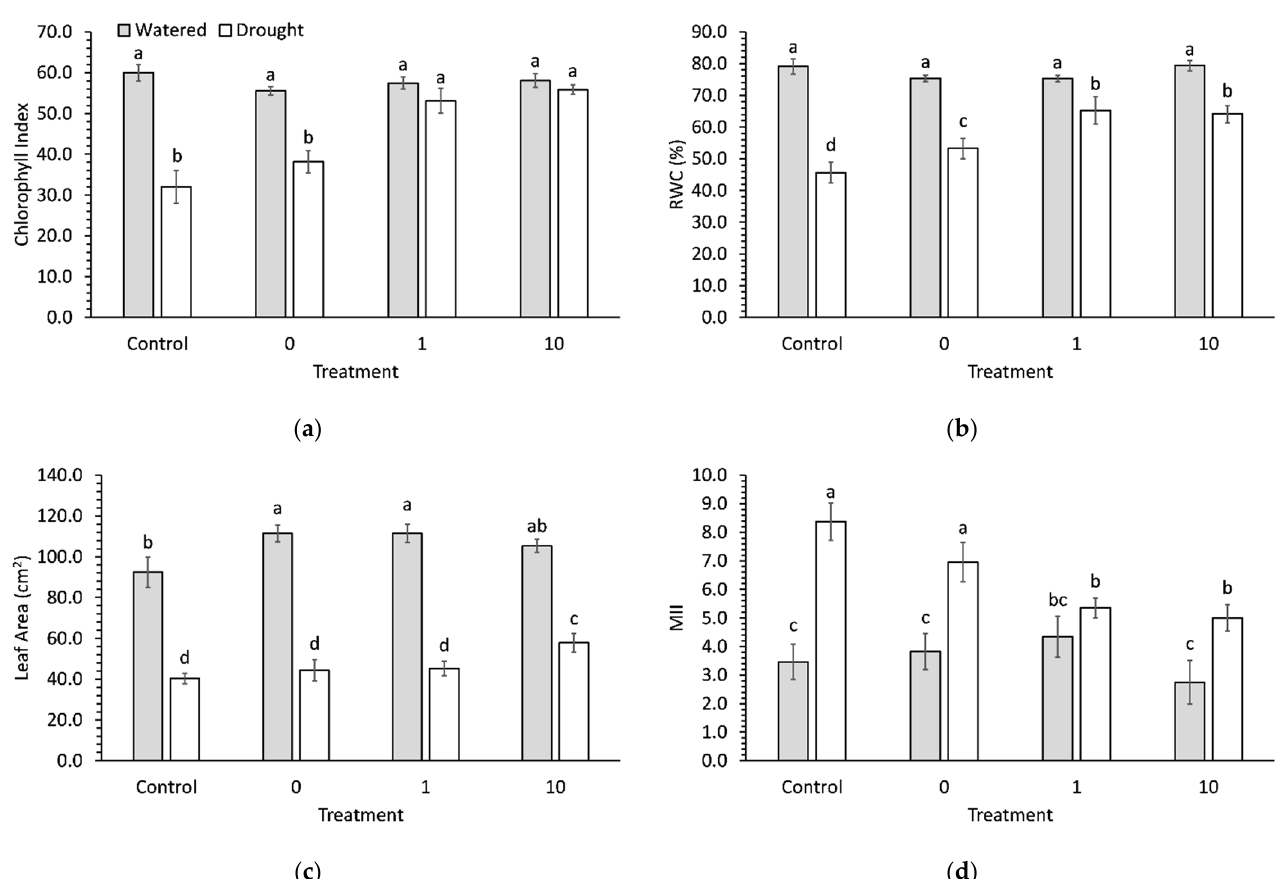
Figure 6. ( a ) Chlorophyll index, ( b ) relative water content, ( c ) leaf area, and ( d ) membrane injury index in 9-week-old broccoli seedlings that were well watered or droughted for 1 week. Each bar represents a mean and error bars represent standard error calculated from 9 replicates. Means with different letters are significantly different ( p < 0.05) as determined by Tukey’s honestly significant difference.